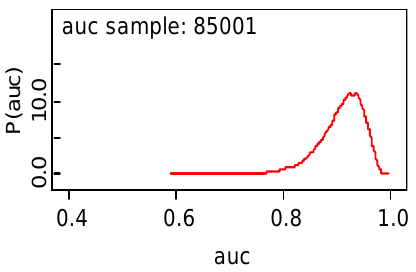
Figure 3. Posterior density of ROC area for head trauma